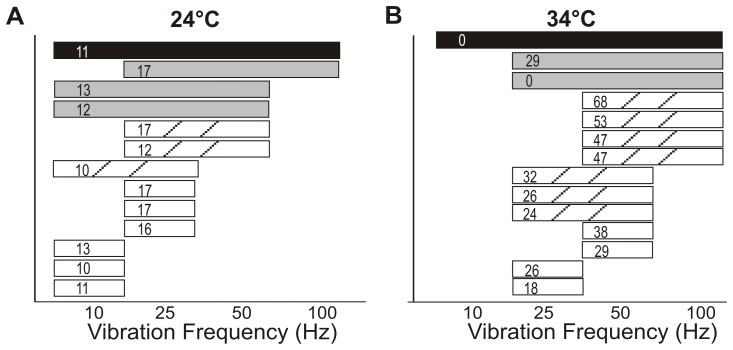
Frequency range of entrainment for individual units.Frequency entrainment ranges for individual units are shown at 24°C (A) and 34°C (B). Each bar represents an individual unit and covers the frequency range that unit could entrain to. The patterns of the bar signify the number of frequencies the unit can entrain to (black  = 4, gray  = 3, hatched  = 2, white  = 1). The unit’s baseline resting discharge is shown in Hz in the bar.